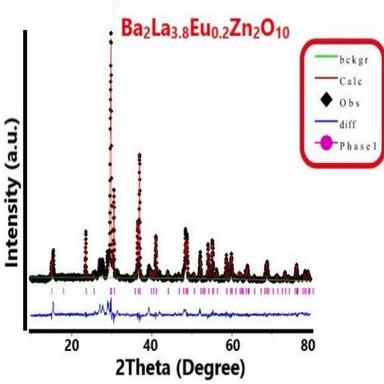
Rietveld refinement results performed over optimized nano sample Ba2La3.8Eu0.2Zn2O10 yielding refined parameters of wRP (Goodness of fit) = 8.43 %, RP (Residual of least squares) = 7.46 % and χ2 = 2.126.